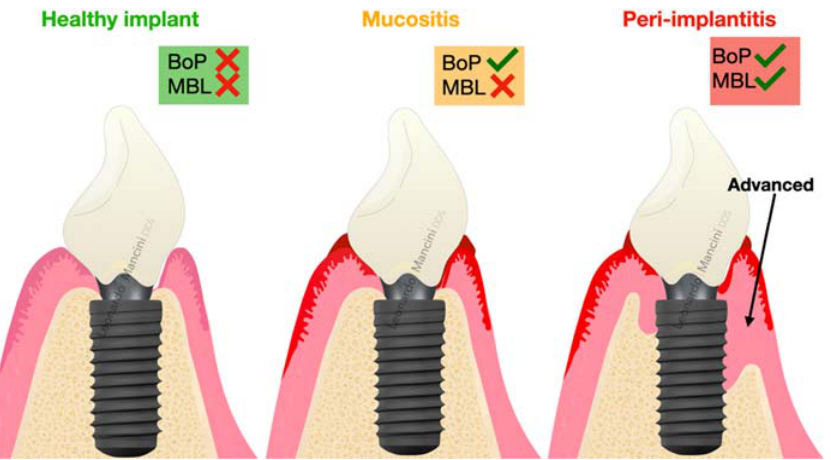
Figure 1. Illustration of the case definition for peri ‐ implant health, mucositis and peri ‐ implantitis in day ‐ to ‐ day clinical practice.